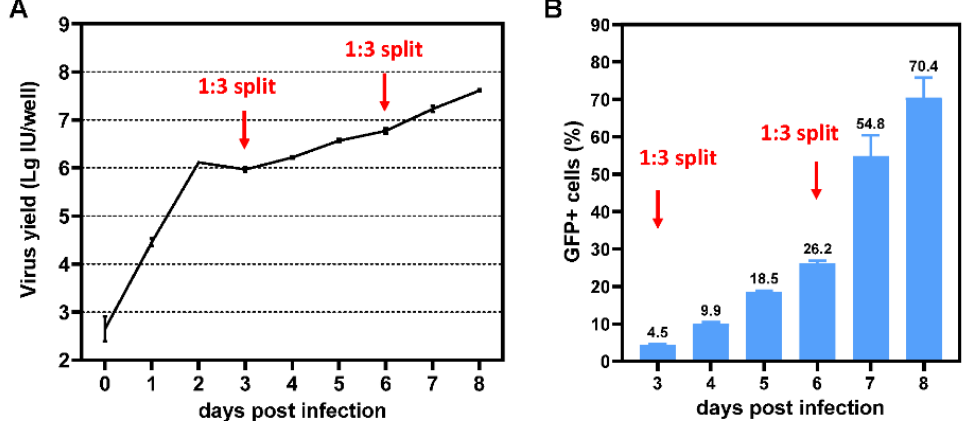
Figure 7. Infection of K562 cells by E3-deleted SAdV-1 vector. K562 cells were infected by SAdV1XE3-